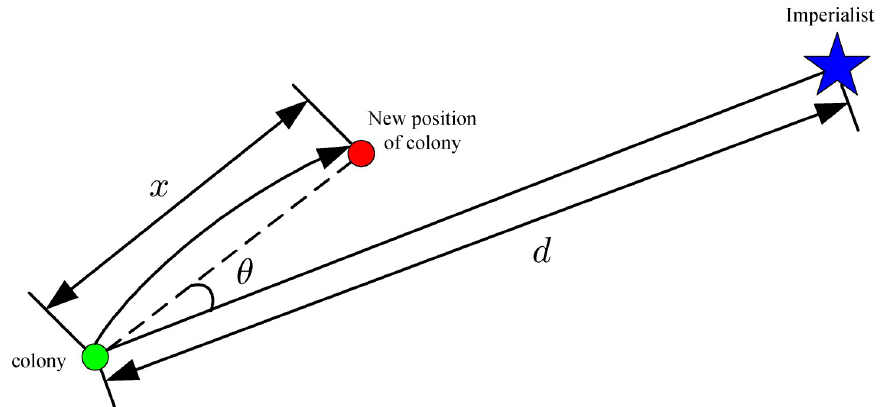
Fig 2. Movement of colonies towards imperialists in the